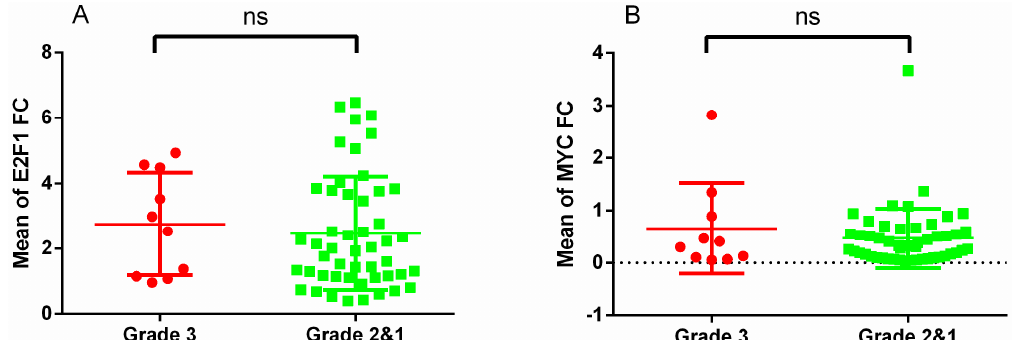
Figure 1. Association between E2F1 ( A ) and MYC ( B ) fold change expression and grades of invasiveness and proliferation (grade 3 vs. grade 2 and 1) in the whole series. Grade 3: proliferative and invasive tumours; grades 2 and 1: non-proliferative and non-invasive tumours. ns, non significant; FC, fold change.